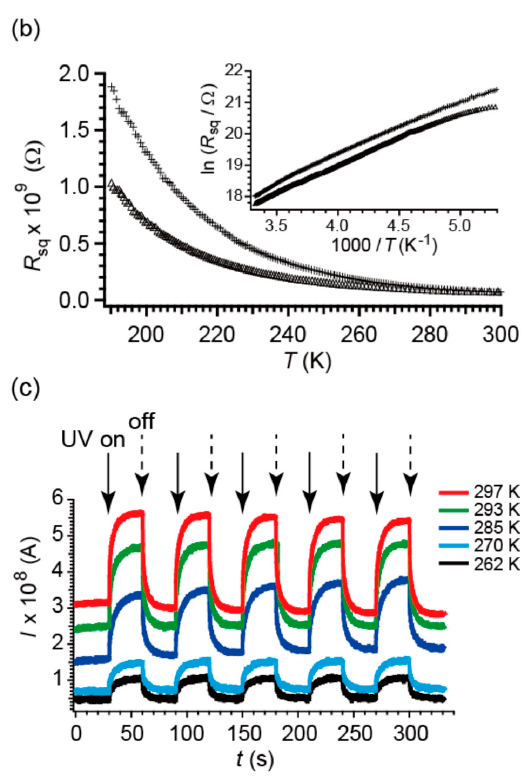
Figure 5. Temperature dependence of electrical resistivity along the b -axis of 2 . ( a ) Resistivity ρ in the dark; (inset) Arrhenius plot of the same data; ( b ) surface resistivity R sq in the dark (crosses) and under UV radiation (triangles); (inset) Arrhenius plot of the same data; ( c ) response of photoconduction to switching the light source on/off.